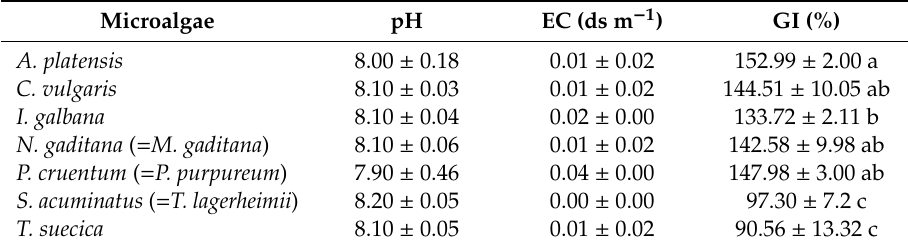
Table 1. Microalgal extracts assessment on cress